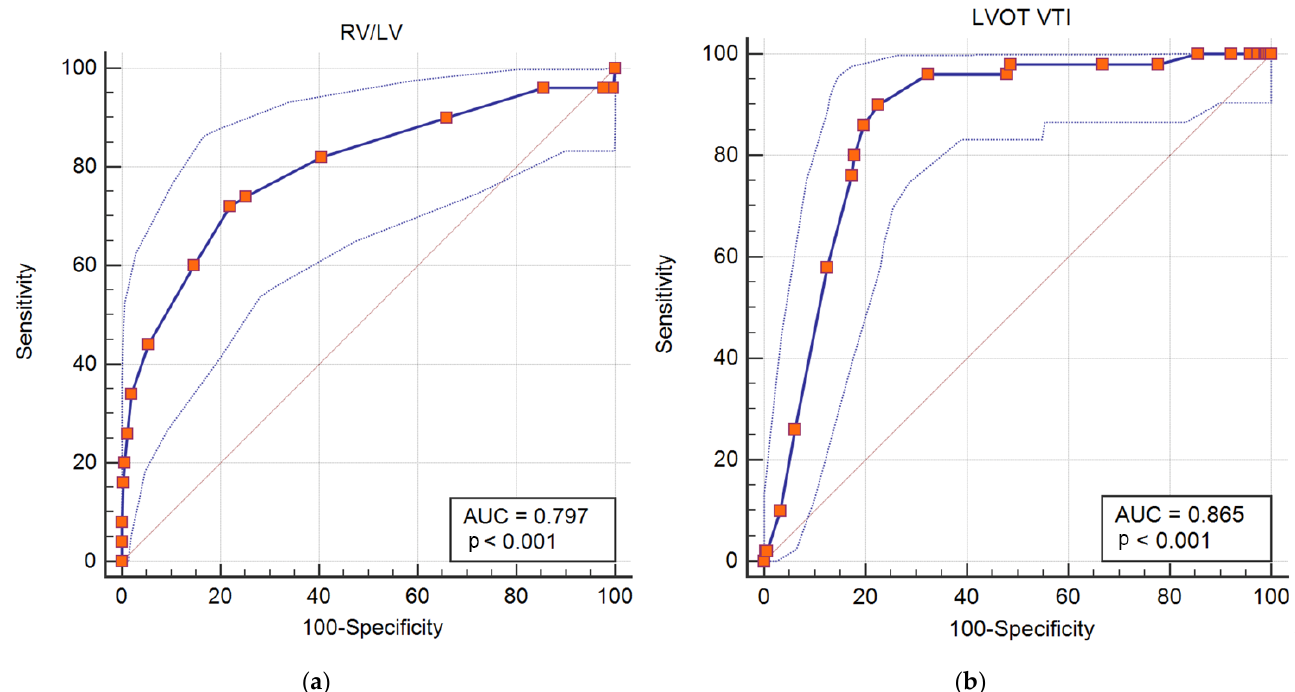
Figure 2. ROC curve for ( a ) RV/LV as predictor of adverse events in intermediate risk PE; ( b ) LVOT VTI as predictor of adverse outcome in intermediate risk PE. The AUC for an RV to LV ratio ≥ 1 was 0.746 (95% CI 0.671–0.821, p < 0.001) and for LVOT VTI ≤ 15 cm was 0.792 (95% CI 0.719–0.864, p < 0.001) (Figure 3). LVOT VTI ≤ 15 cm had a sensitivity of 76% and a specificity of 82.4% in predicting adverse in hospital out- come. The positive predictive value was 38% and the negative predictive value was 95% for an LVOT VTI ≤ 15 cm. Figure 3 . ROC curves for adverse event prediction in intermediate risk PE . RV to LV ratio ≥ 1 is a predictor of adverse outcome with a sensitivity of 74%, and a specificity of 75.1%. The positive predictive value for a RV to LV ratio ≥ 1 was 30% and the negative predictive value was 95%. A combined criteria of RV/LV ratio ≥ 1 and an